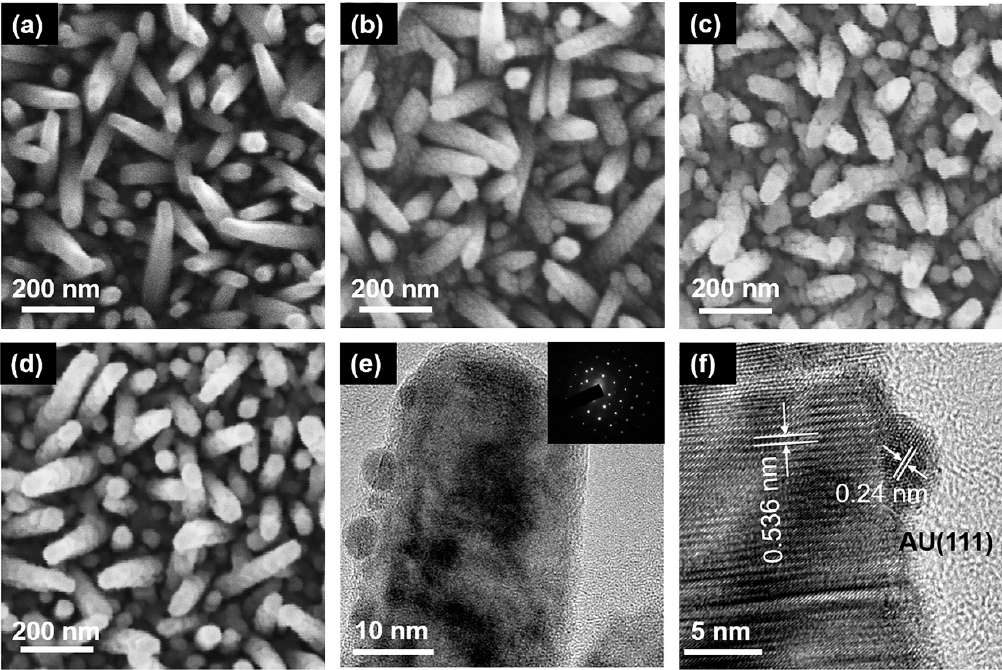
Figure2. SEMimagesofInGaN( a )bareNRs, ( b )Au5@NRs, ( c )Au10@NRs, and( d )Au15@NRs. ( e )TEM Figure 2. SEM images of InGaN ( a ) bare NRs, ( b ) Au5@NRs, ( c ) Au10@NRs, and ( d ) image of Au@NR, inset is the corresponding selected area electron di ff raction. ( f ) High-resolution TEM Au15@NRs. ( e ) TEM image of Au@NR, inset is the corresponding selected area electron image of diffraction. ( f ) High-resolution TEM image of Au5@NR.